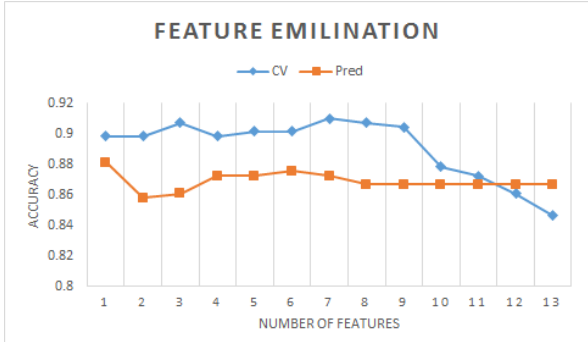
Figure. 4. Accuracy in case of Australian dataset